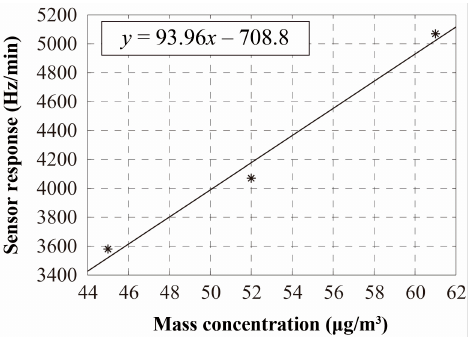
Figure 20. SAW based PM 2.5 sensor response changes with the particle mass concentration.